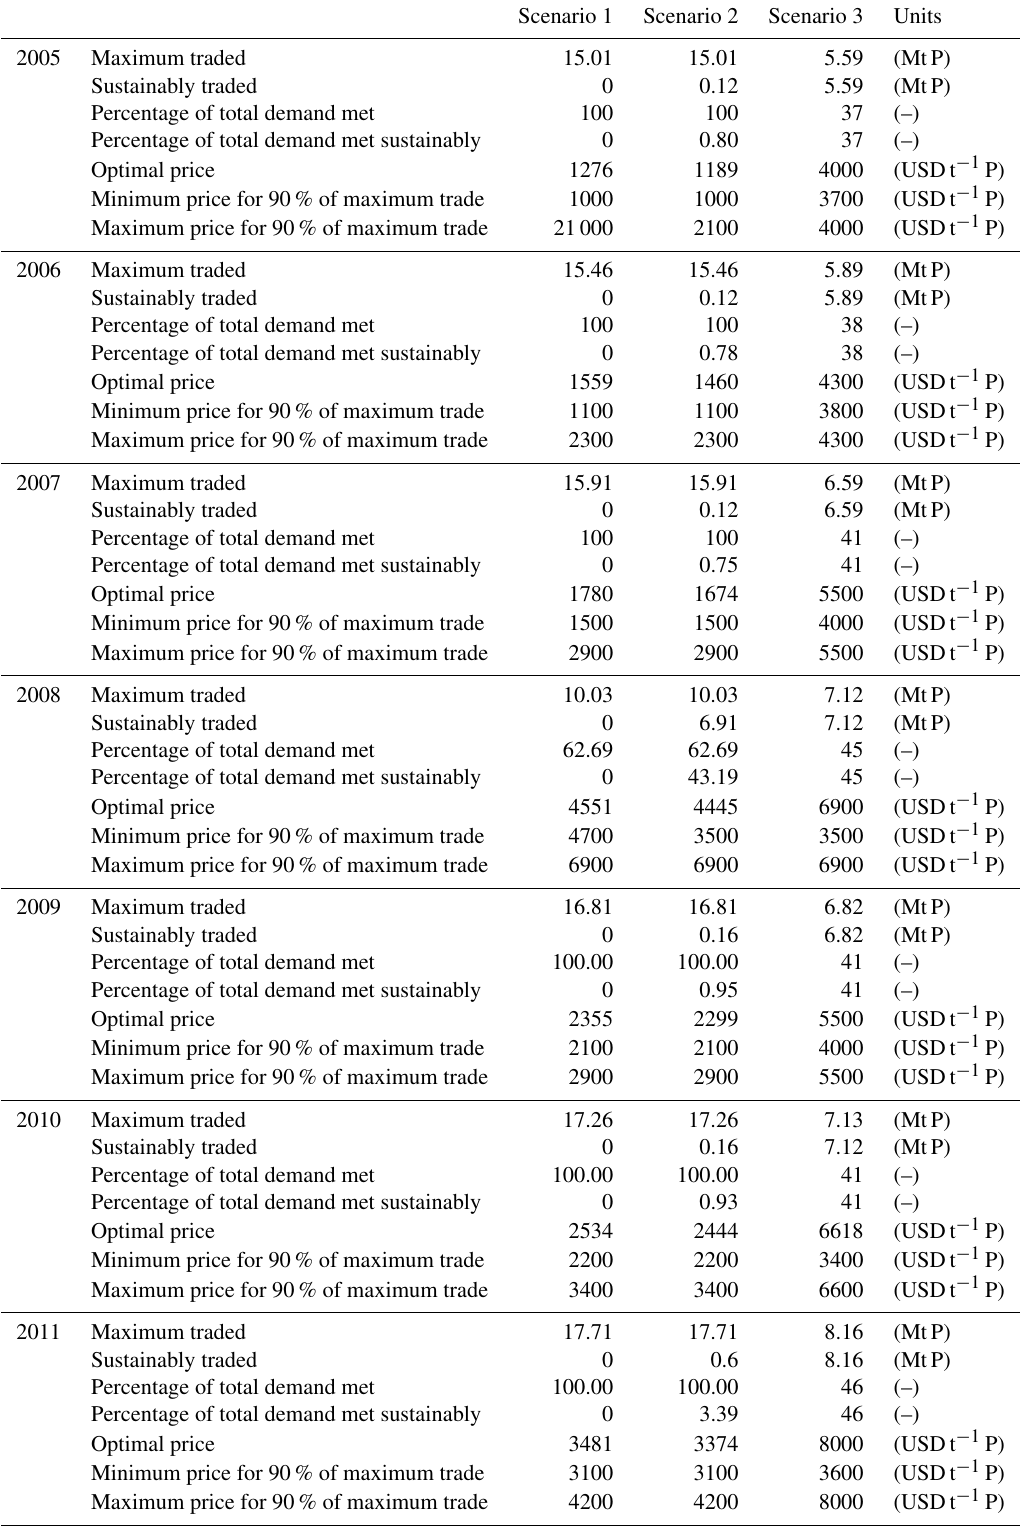
Table 2. Price ranges and phosphorus quantities traded per scenario for all simulation